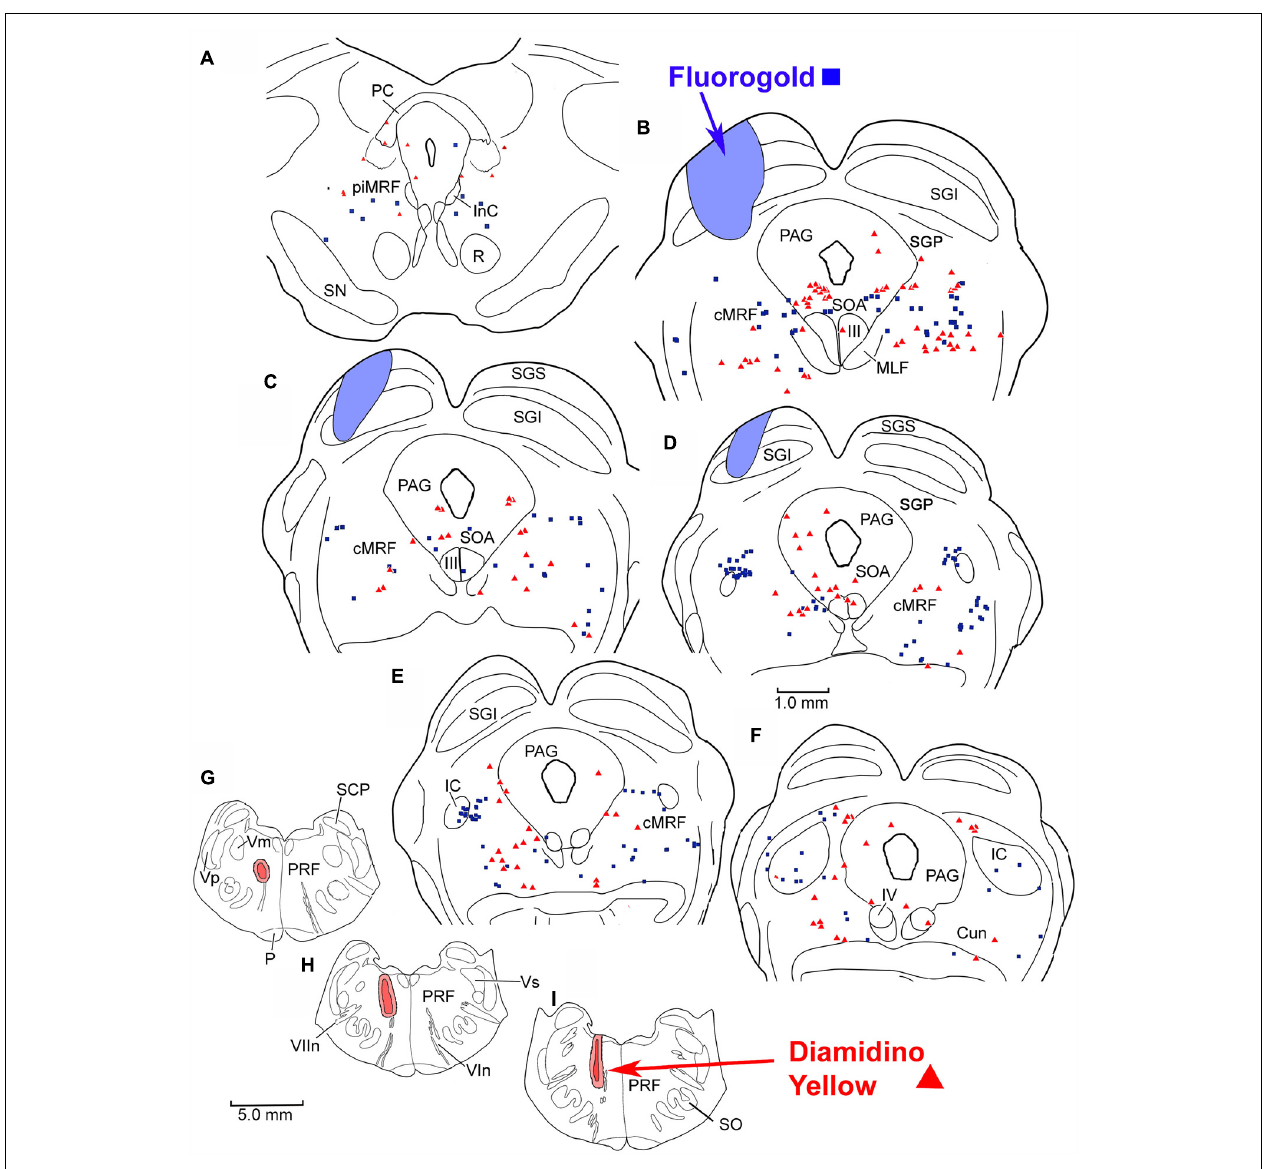
FIGURE 4 | Injection sites and distribution of labeled reticulotectal neurons (cid:2) and pontine reticuloreticular neurons (cid:3) in MRF (A–F) following a fluorogold injection in the SC (A–D) and a diamidino yellow injection into the lateral PRF